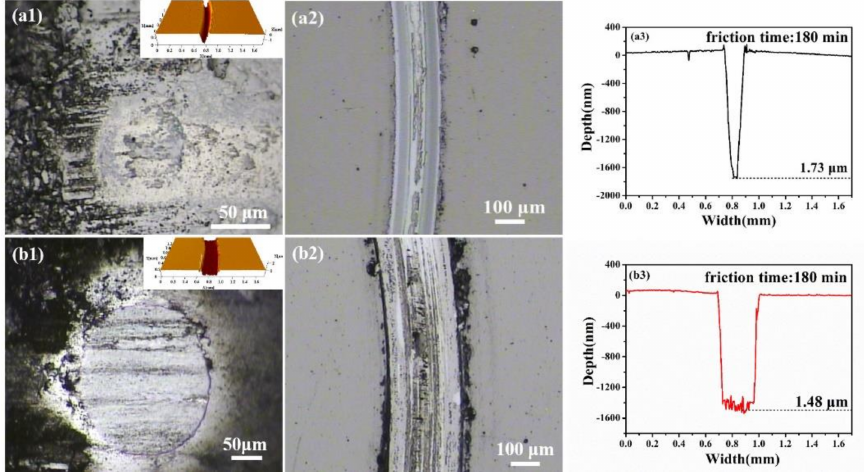
Figure 8. The optical micrographs of balls scars and wear tracks when steel balls slid against ( a1 , a2 , a3 ) N6 film and ( b1 , b2 , b3 ) N10 film in an ultrahigh vacuum for 1.8 × 10 5 revolutions. The three-dimentional surface images of wear tracks are inserted in ( a1 , b1 ), and ( a3 , b3 ) displays the corresponding two-dimentional